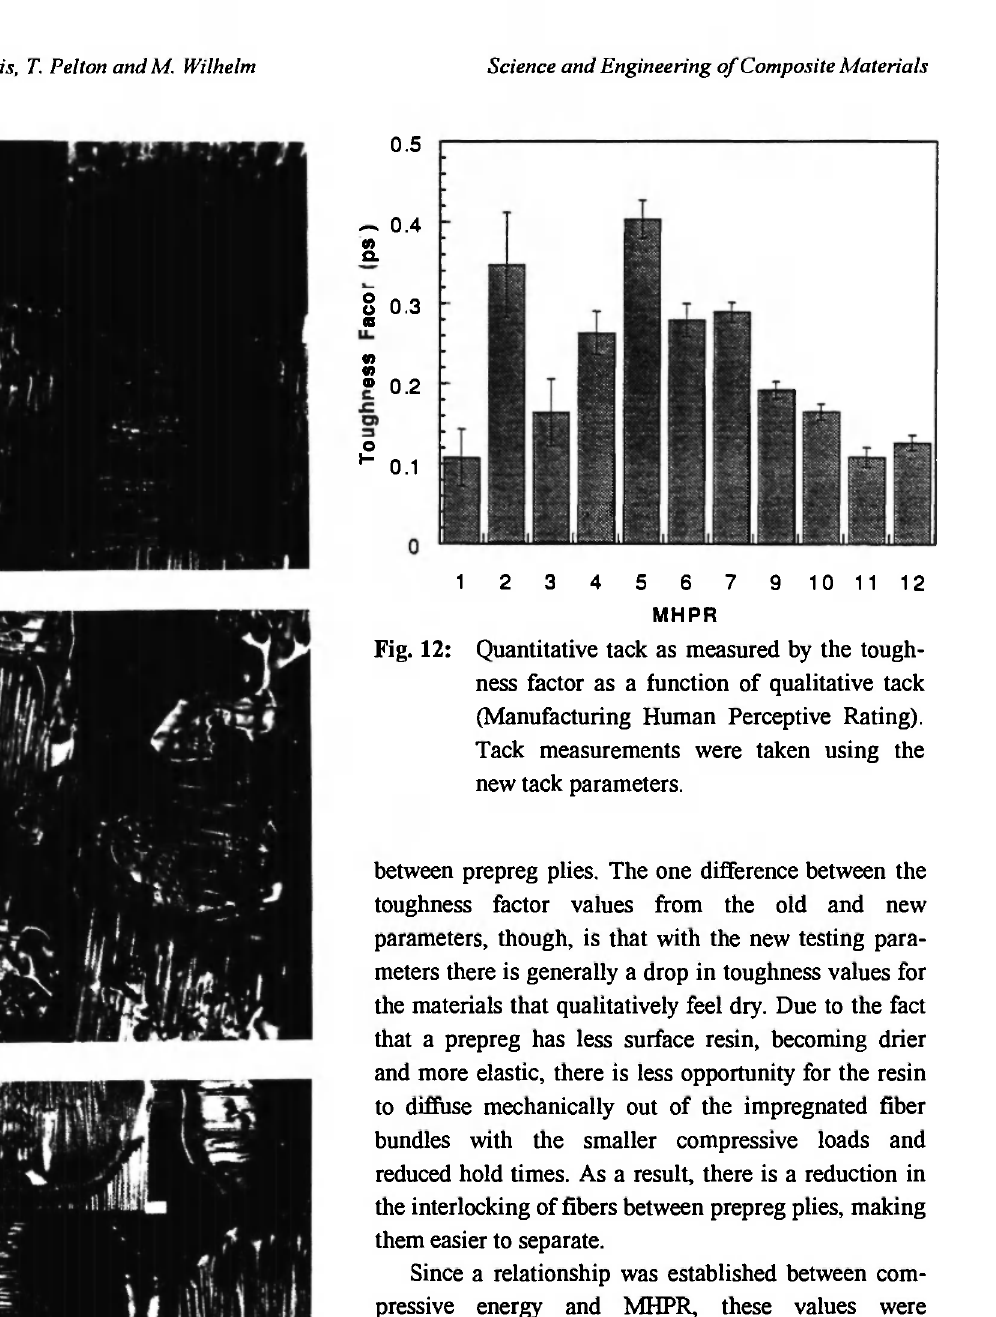
Fig. 11: Optical photo-micrographs of the prepreg surfaces for a) a dry feeling material, b) an ideal tack feeling material, c) a very tacky feeling material.